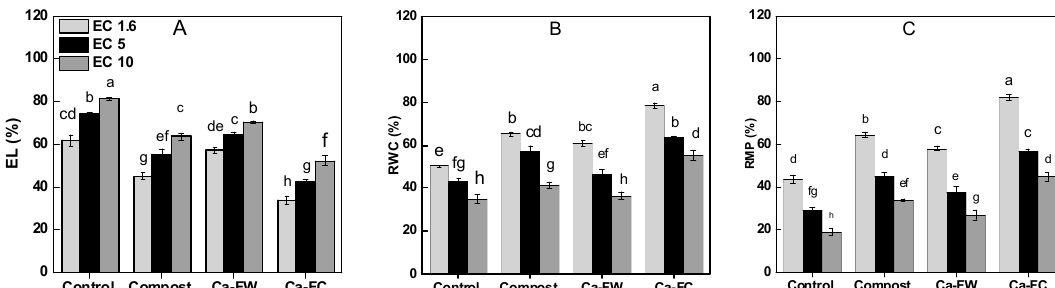
Figure 3. Effect of compost, Ca-FW, and Ca-FC on physiological parameters of maize ( Zea mays L.) under saline–sodic soil conditions. (Note: Ca-FW = calcium based fertilizer industry waste; Ca-FC = calcium-fortified compost; EL = electrolyte leakage; RWC = relative water contents; RMP = relative membrane permeability. Quantities sharing similar letters are statistically different from each other at p ≤ 0.05).